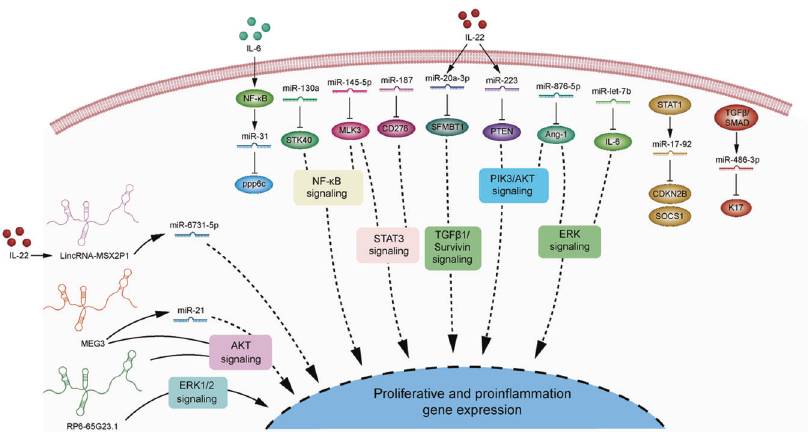
Fig. 3 Non-coding RNAs and their involved signaling pathways in psoriasis. Non-coding RNAs play pivotal roles in the pathogenesis of psoriasis. In keratinocytes, they can affect cell proliferation, apoptosis, differentiation, and in fl ammatory response through targeting multiple signaling pathways, such as NF- κ B signaling, STAT3 signaling, ERK signaling, AKT signaling, etc. Also, expression of some of microRNAs are found to be regulated by NF- κ B, STAT, or TGF β signaling. MEG3 maternally expressed gene 3, ppp6c protein phosphatase 6, STK40 serine/ threonine kinase 40, MLK3 mixed-lineage kinase 3, SFMBT1 Scm like with four mbt domains 1, PTEN phosphatase and tensin homolog, Ang1 Angiopoietin-1, CDKN2B cyclin-dependent kinase inhibitor 2B, SOCS1 suppressor of cytokine signaling 1, K17 keratin